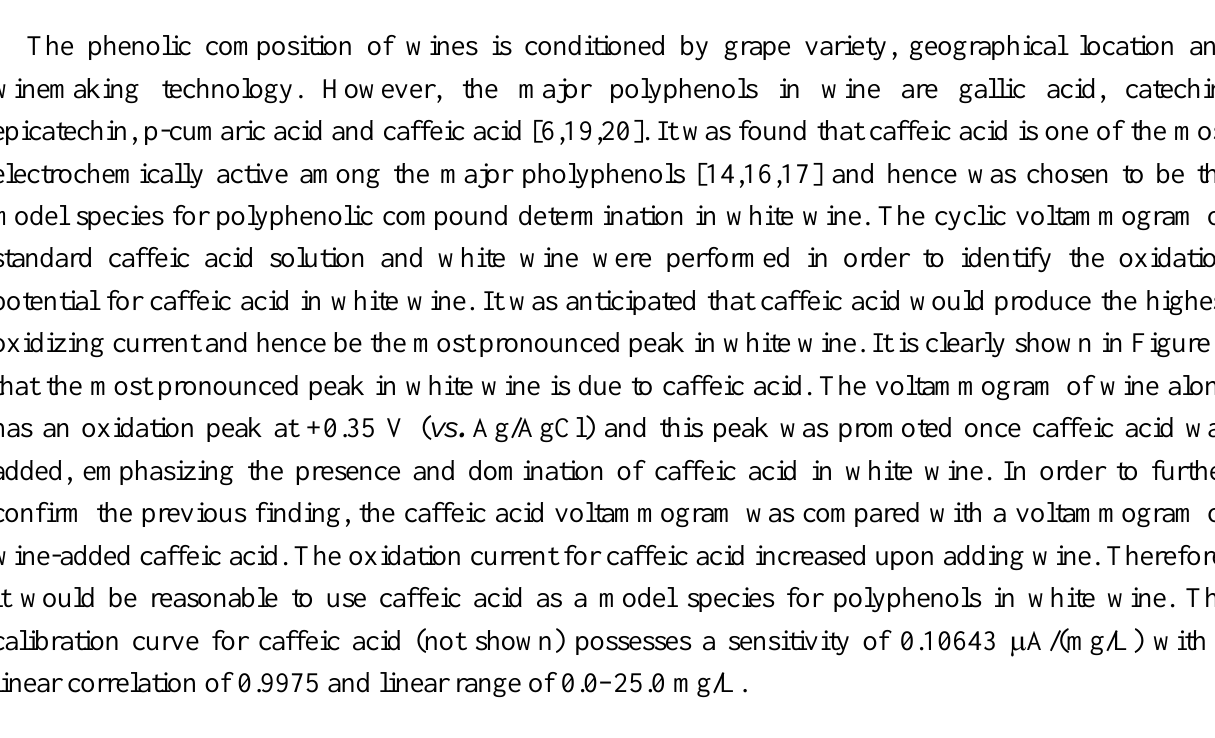
Figure 1. Voltammograms of caffeic acid, wine and caffeic acid-added wine showing that the most electroactive species in white wine is caffeic